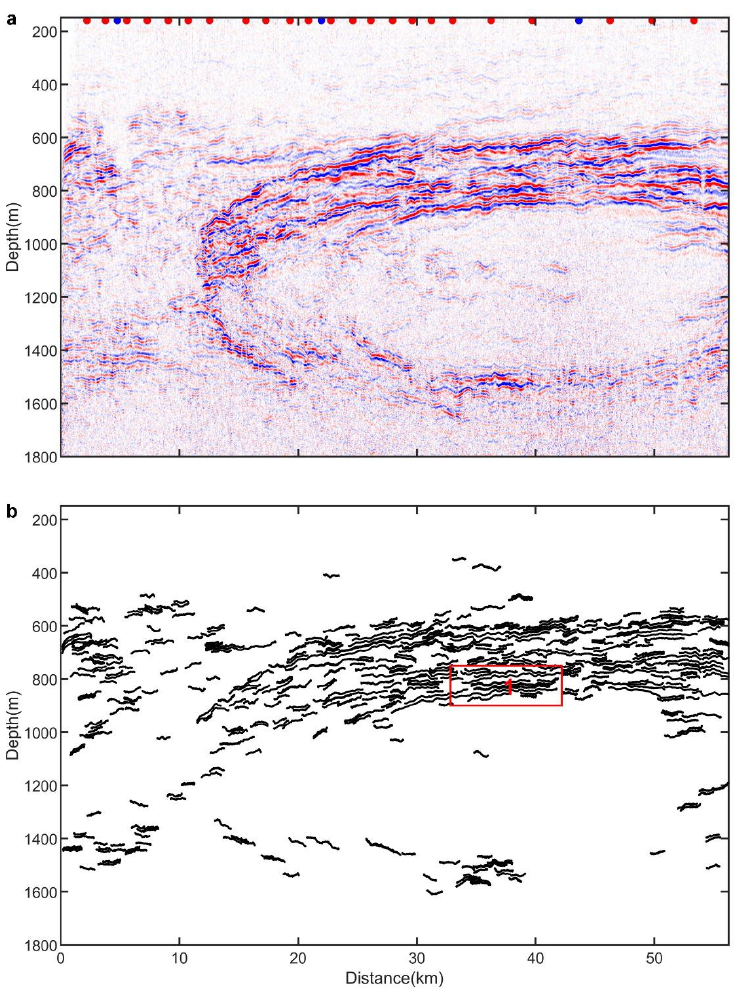
Figure 2. The seismic stack section and the tracked reflectors of seismic line GOLR12. ( a ) Seismic stack section, where red/blue ribbons represent seismic reflections of negative/positive amplitudes, respectively. Red (bot) dots represent the locations of 24 XBTs (3 CTDs). ( b ) The tracked reflectors that are greater than 1 km — box 1 marked by a red rectangle — will be spectrally analyzed further.